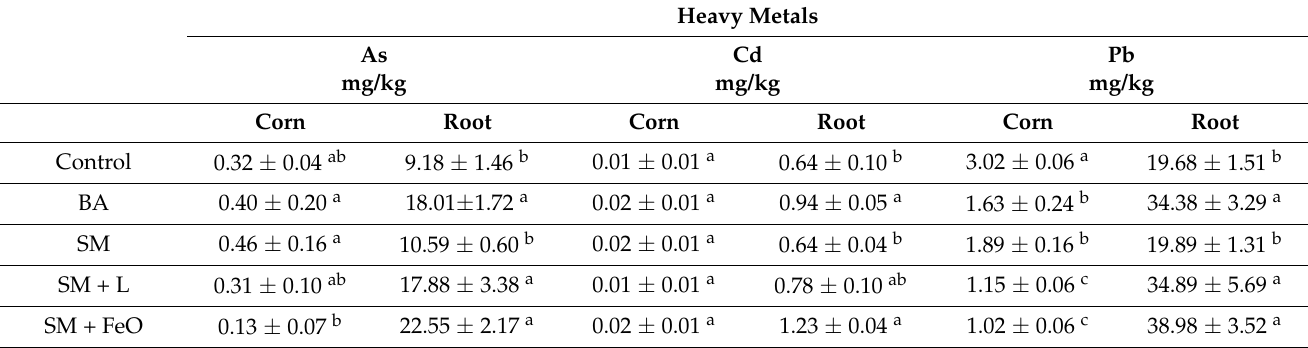
Table 5. Heavy metal concentration in corn and root of